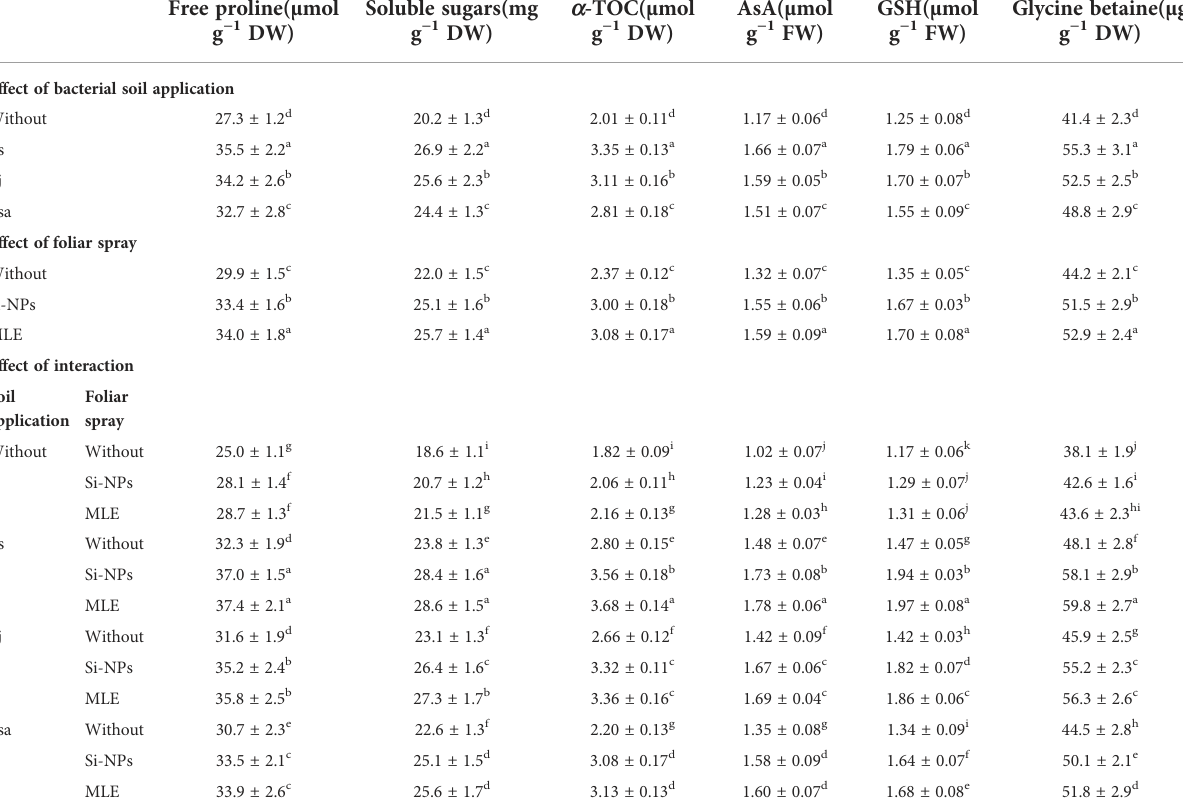
TABLE 6 Changes in free proline, soluble sugars, a -tocopherol ( a -TOC), ascorbate (AsA), and glutathione (GSH), and glycine betaine (GB) of heavy metal – stressed spinach plant in response to bioremediation of heavy metals bacterial applied as soil inoculation and/or foliar spray with MLE or